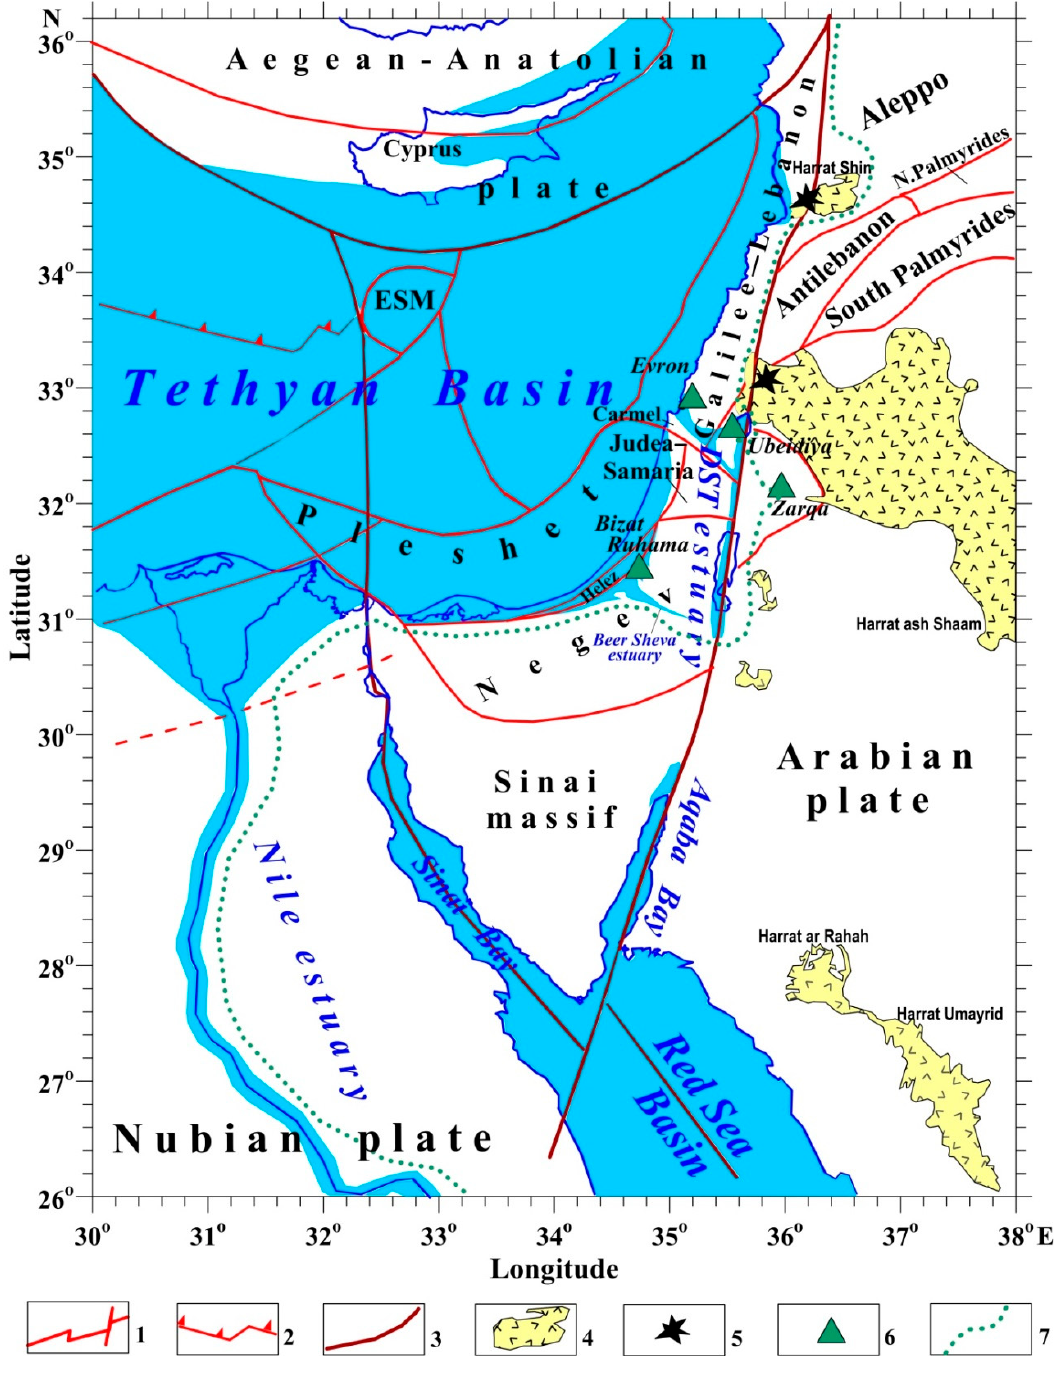
Figure 8. Map of the Levantine Corridor with the significant tectono-geological elements. (1) in- terplate faults, (2) Mediterranean Ridge, (3) intraplate faults, (4) Pliocene trap fields, (5) Plio- cene-Pleistocene volcanoes, (6) ancient hominin sites, (7) Levantine